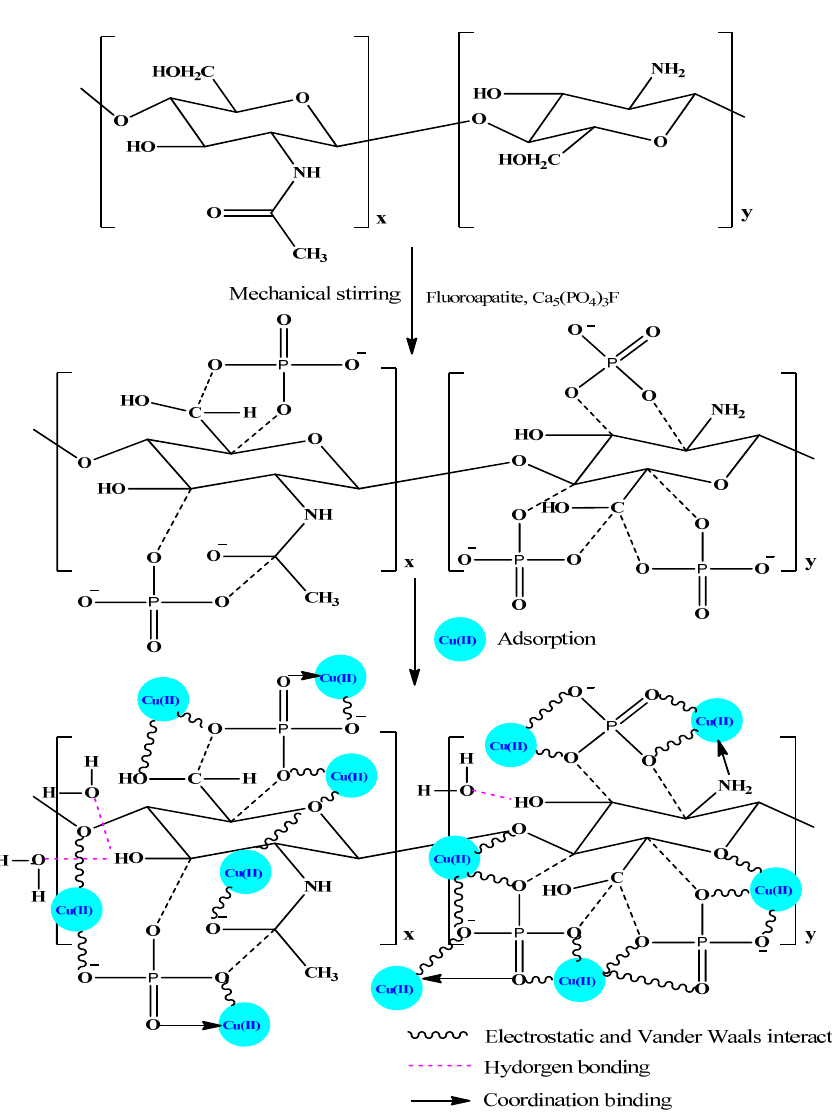
Scheme 1. Schematic representation of CH-TNP composite synthesis and Cu(II) binding on